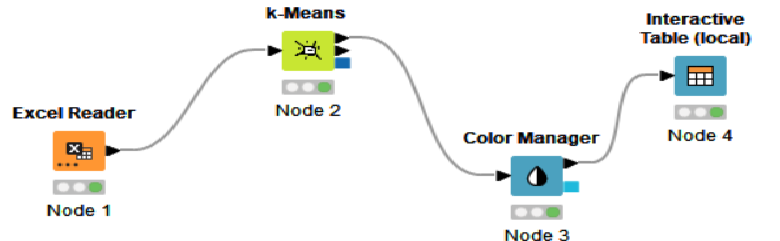
Figure 10. The workflow of KNIME with nodes regarding digitalization indicators. Source: authors’ compilation in KNIME analytics platform.